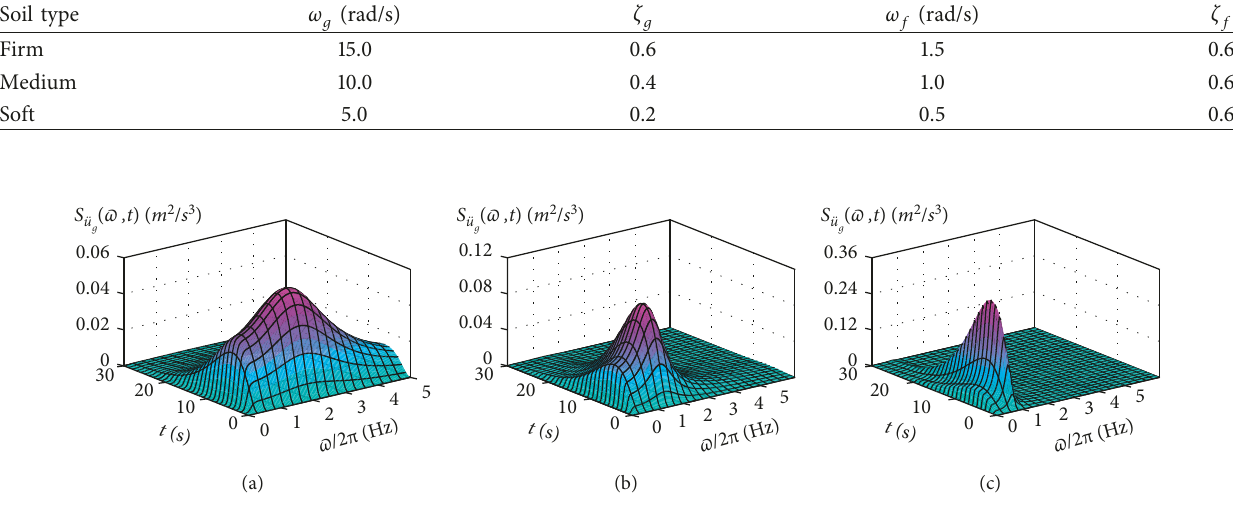
Figure 5: Evolutionary PSD function as per (6) for three soil conditions: (a) firm; (b) medium; (c)